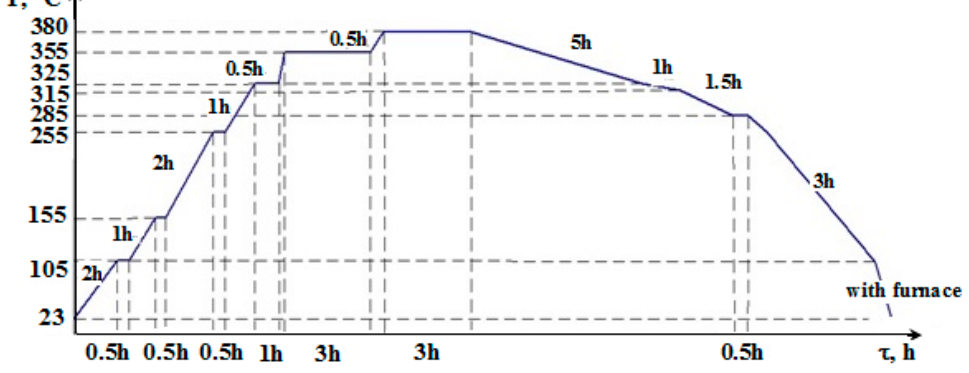
Figure 10. Graph of cascade heat treatment during sintering PTFE composite.